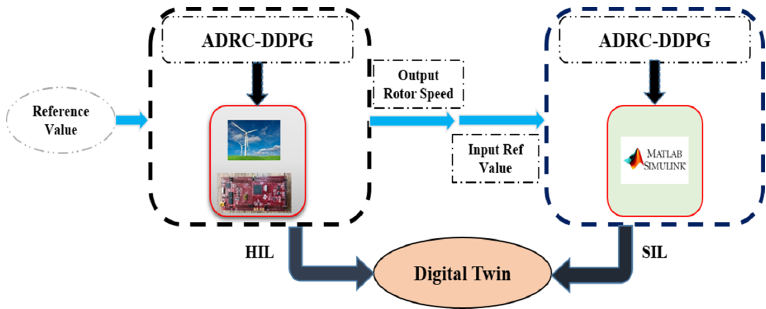
Figure 7. A proposed strategy for the combination of HIL and SIL testing.